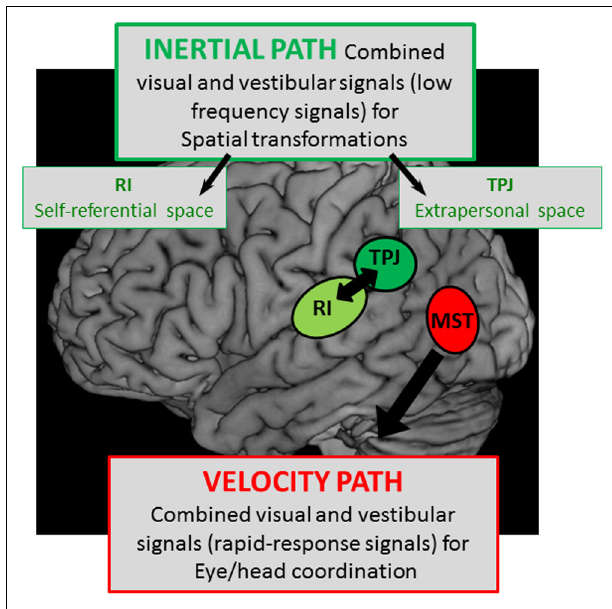
FIGURE 8 | Schematic representation of two hypothetical cortical pathways with – a velocity path including the middle superior temporal cortex (MST) where visual and vestibular signals are mediated to serve for rapid-responses during eye/head coordination, and – an integration pathway of visual and vestibular signals with low kinematic (low frequencies) in the temporo-parietal junction (TPJ) and the retro-insular cortex (RI) possibly involved in the construction respectively of the extrapersonal and self-referential